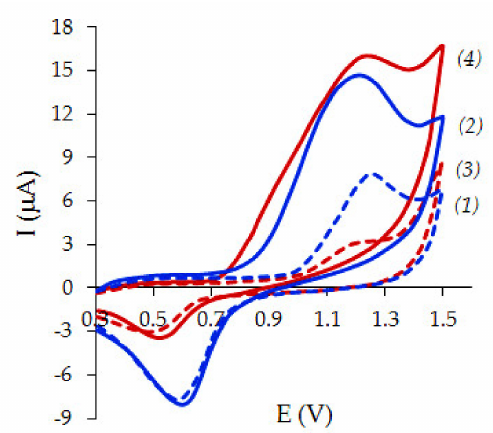
Figure 3. Cyclic voltammograms on the phytosynthesized gold nanoparticles phyto-Au / FCVE ( 1 , 2 ) and phyto-Au / TrX100 / FCVE ( 3 , 4 ) in BRB (pH 3) in the absence ( 1 , 3 ) and in the presence of 0.02 mM NO 2 − ( 2 , 4 ). Potential scan rate: 0.05 Vs − 1 .